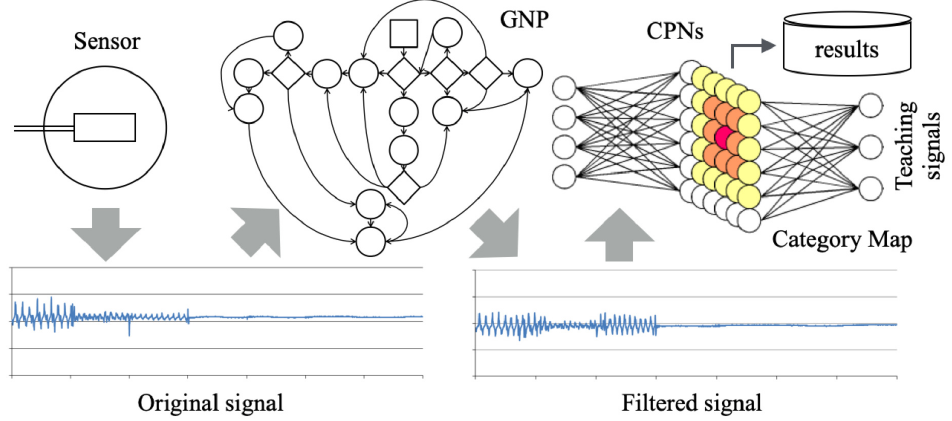
Figure 1. Overall structure of our proposed method including our originally developed sensor.